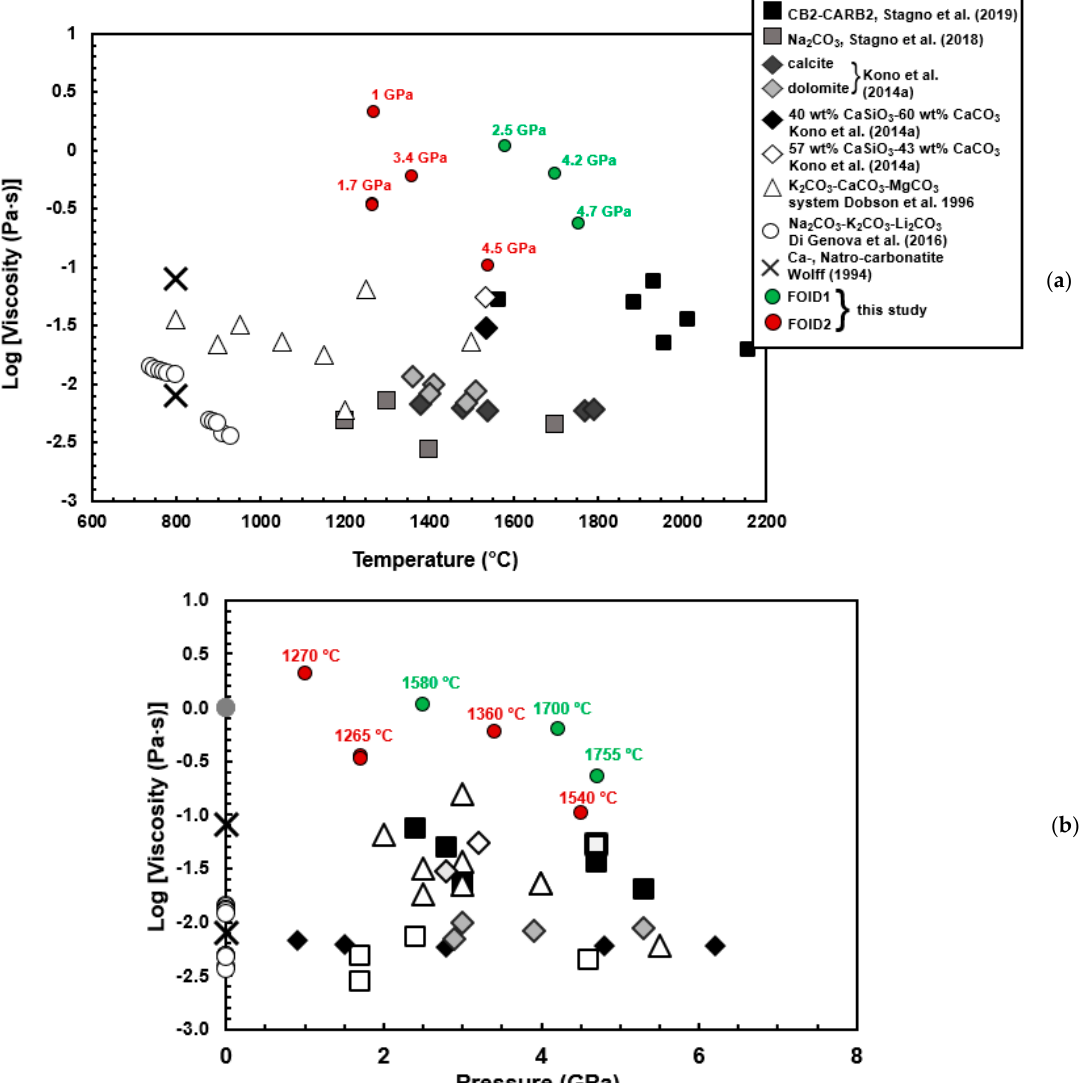
Figure 2. Shown are the obtained viscosity data plotted as a function of ( a ) temperature and ( b ) pressure. Data from literature are reported for comparison [10–13,26,27]. The uncertainty in our viscosity measurements is reported in Table 2.